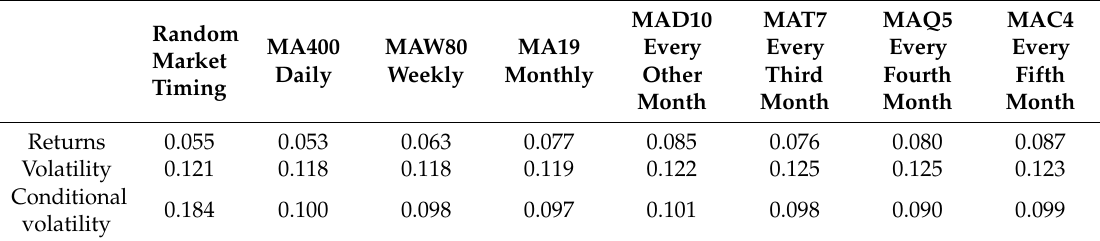
Table 2. The 400 trading-day rolling window, average annualized returns, volatilities, and conditional